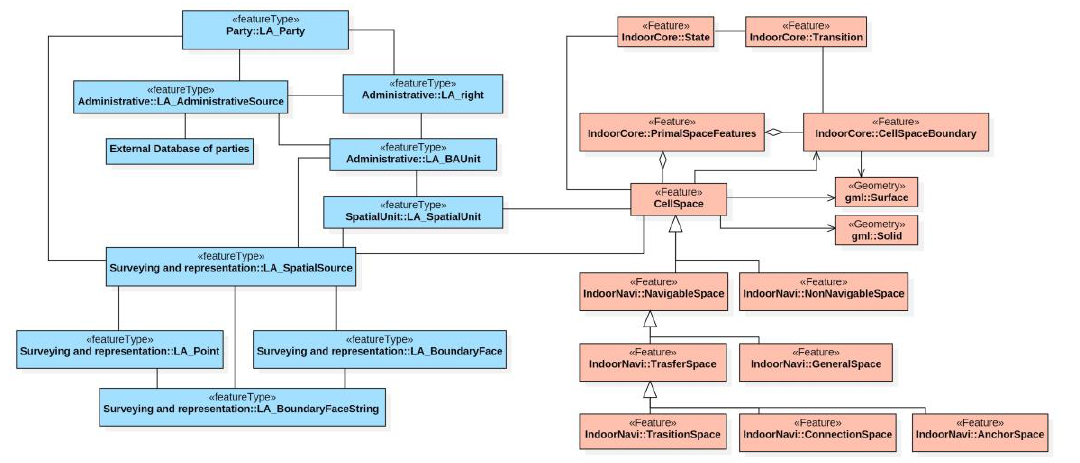
Figure 1. The conceptual model of LADM (blue) and IndoorGML (red) (Alattas et al. 2017)